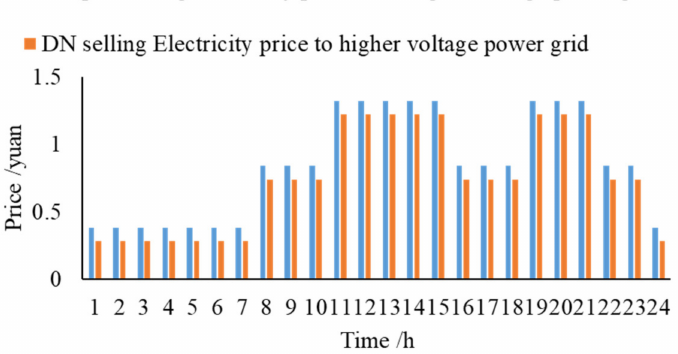
Figure 3. Time of use price information.